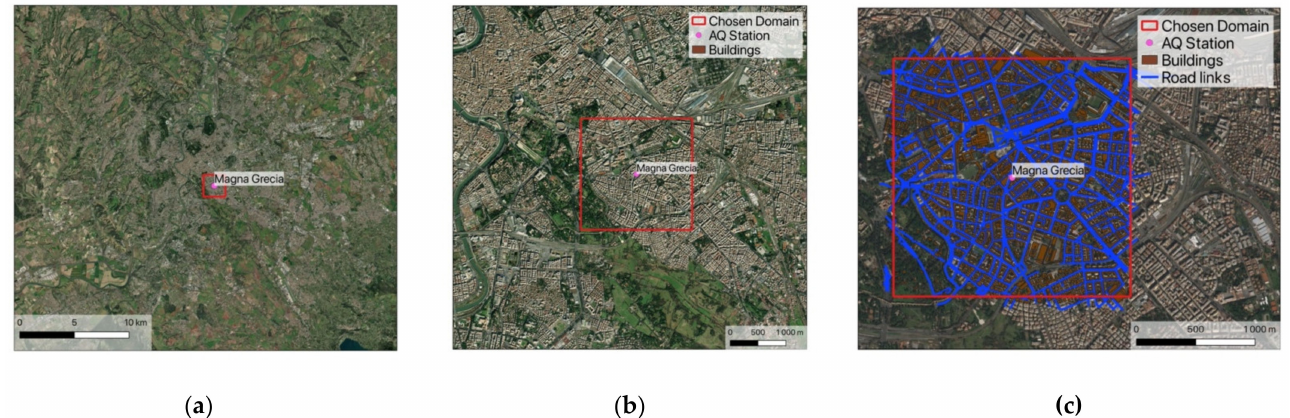
Figure 2. Simulation domain (red square, with a resolution of 3 m) centered in the AQ station of Magna Grecia (pink point). ( a ) shows the domain within the Rome urban area, ( b ) at increased zoom level, ( c ) includes (in blue) the street segments for which the FCD based emissions are available.